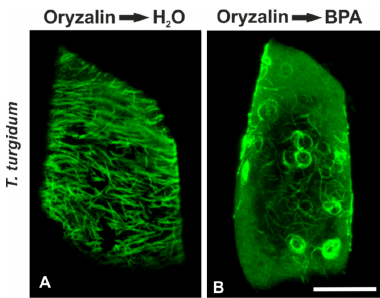
Figure 6. Maximum projections of CLSM sections, after tubulin immunolocalization in interphase; T. turgidum root cells recovering after oryzalin treatment, either in ( A ) water or in ( B ) BPA solution. Scale bar: 10 μ m.